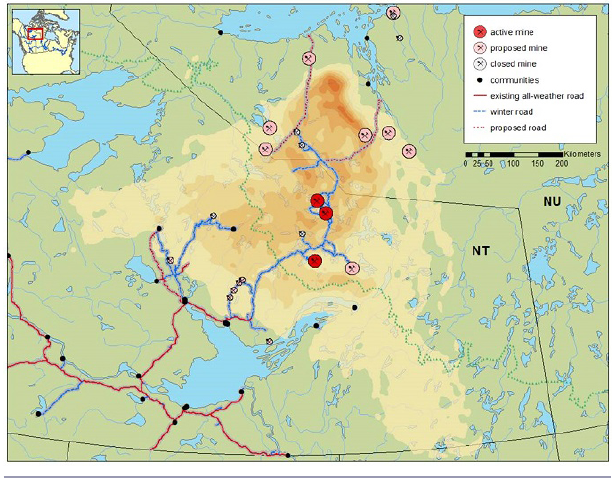
Fig. 1. Annual range of the Bathurst caribou herd, showing the locations of current and proposed mines and access